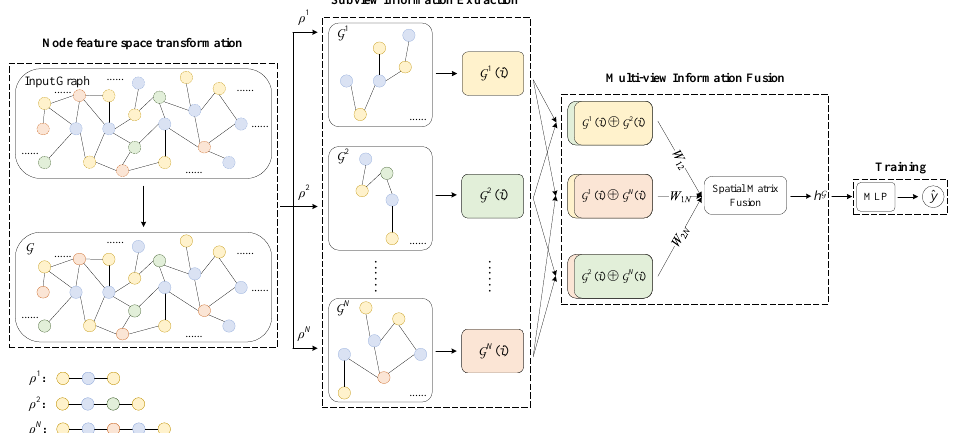
Figure 2. The framework of